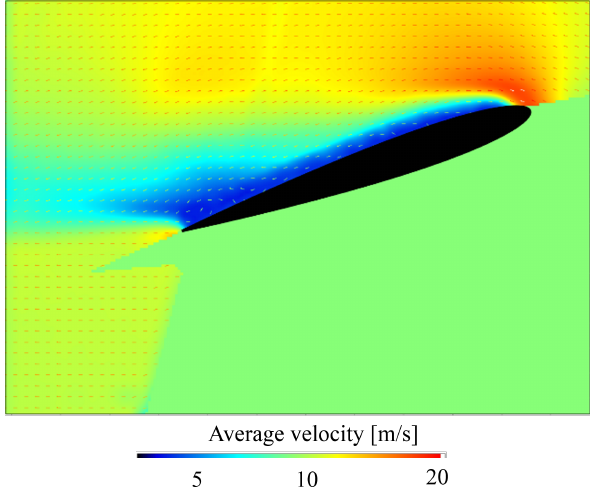
Figure 25. Velocity field at Re = 200,000 and α = 16 ◦ and DBD actuation at frequency f = 41Hz ( left ) and f = 133 Hz ( F + c = 1 ) ( right ).